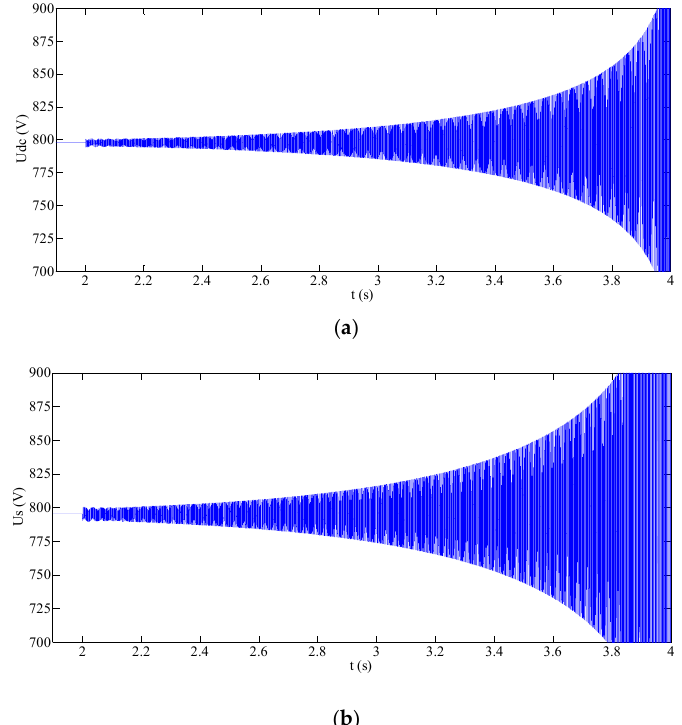
Figure 6. The simulation result when P s changes from 90kW to 98kW: ( a ) The DC bus voltage; ( b ) The DC-side voltage of VSC2.